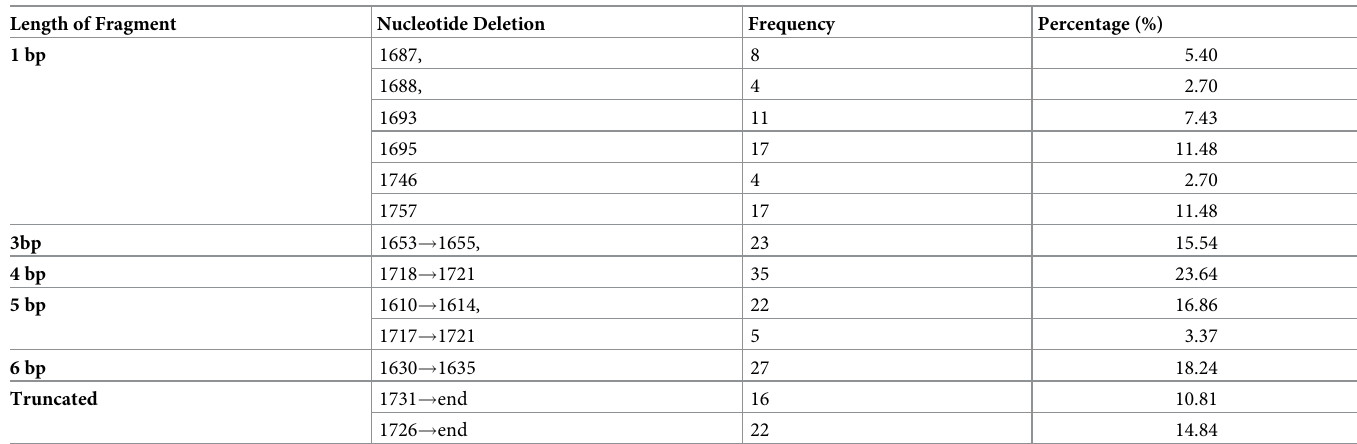
Table 3. Deletion mutation in the Enh-II region of